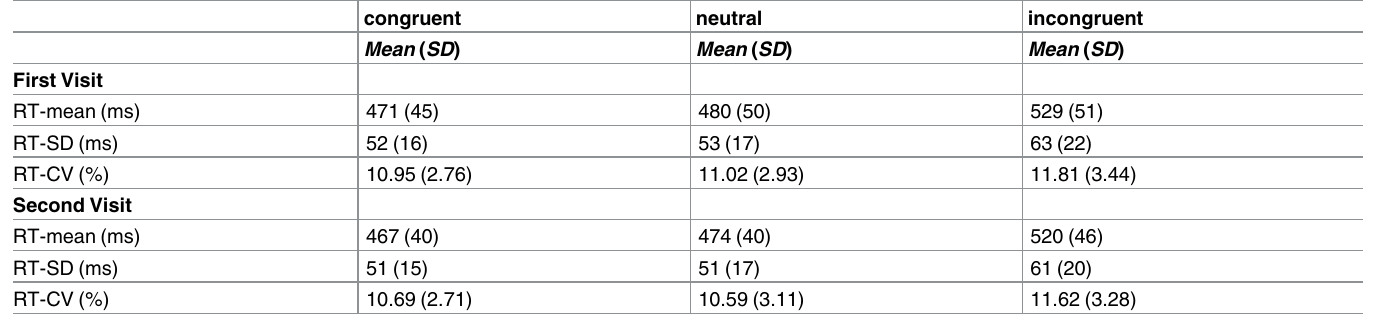
Table 1. Conventional measurements of the Eriksen flanker task (EFT) for three conditions.